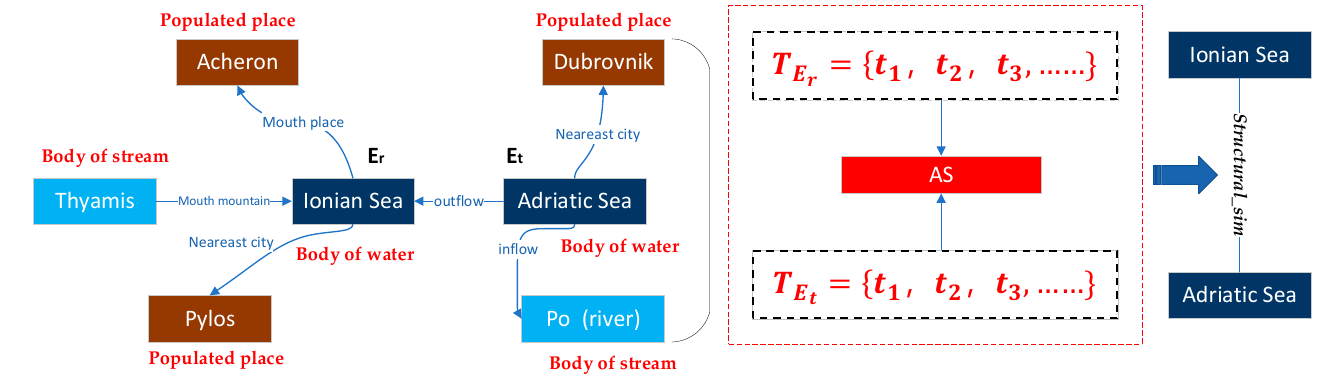
Figure 5. Method of constructing the structural similarity network.